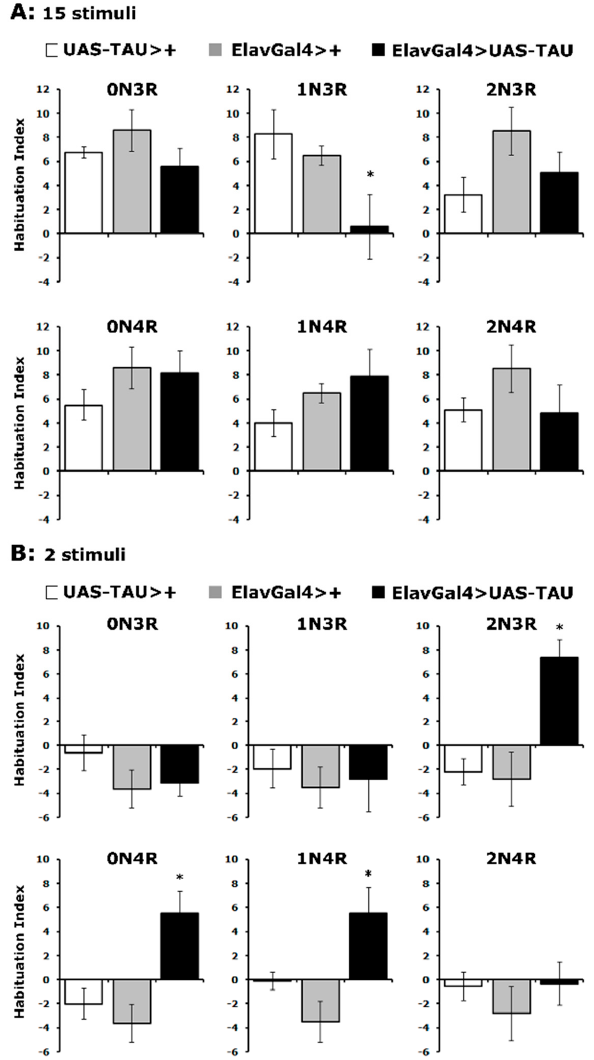
Figure 5. hTau isoforms affect differentially habituation to footshocks. Habituation following exposure to 15 ( A ) or 2 footshocks ( B ) of flies accumulating pan-neuronally the indicated hTau isoforms (black bars) compared with driver and transgene heterozygotes (grey and white bars). The means ± SEMs are shown for n ≥ 7 for all genotypes. Stars (*) indicate significant differences from both controls. Statistical details in Supplemental Table S5.